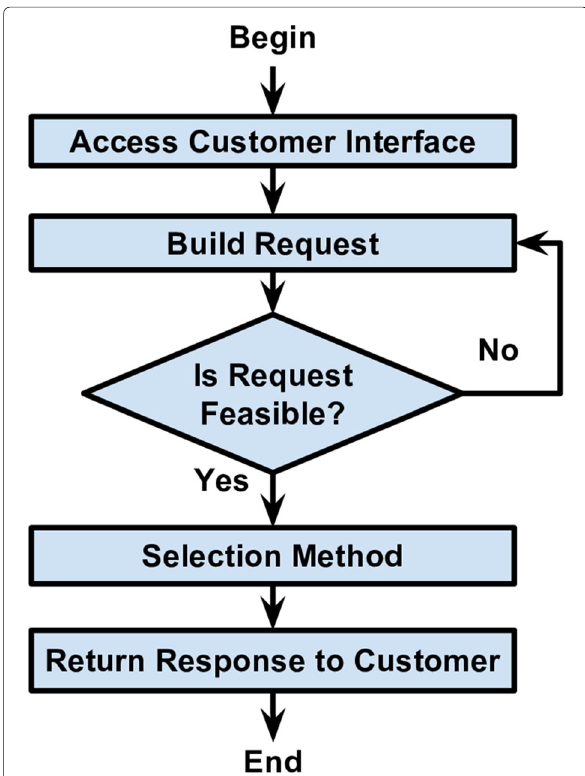
Fig. 2 System utilization flowchart from a cloud user point of